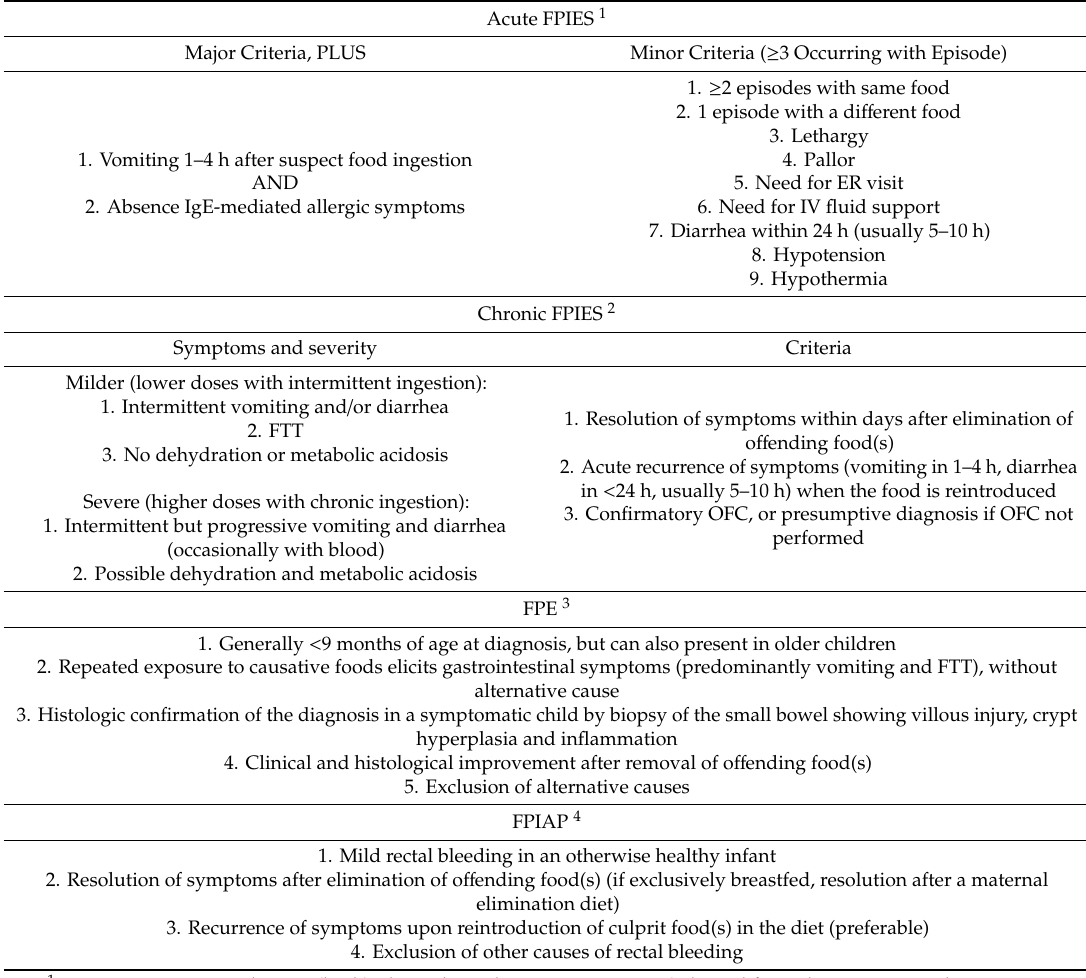
Table 3. Diagnostic criteria of non-IgE-mediated gastrointestinal food